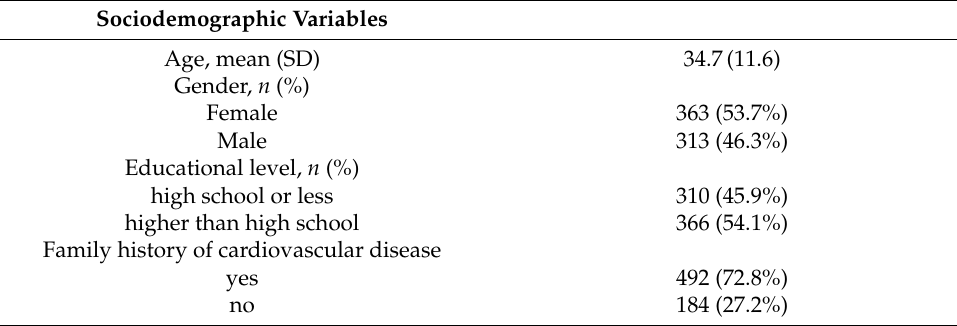
Table 1. Sociodemographic characteristics of the sample ( n =